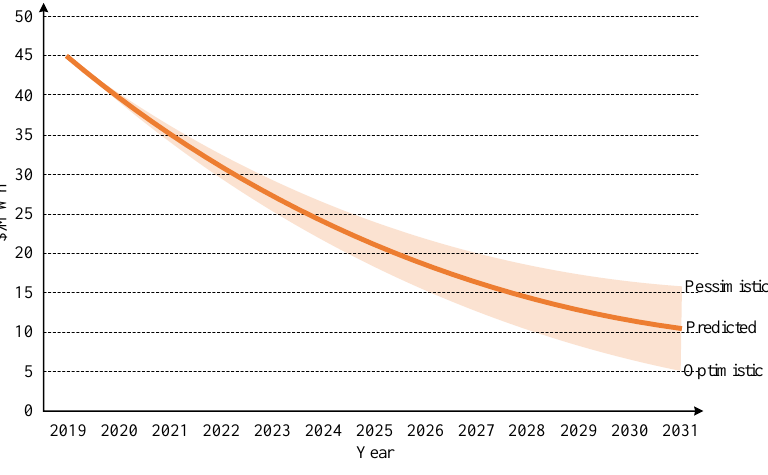
Figure 21. The predicted price points of solar energy in the U.S. up to